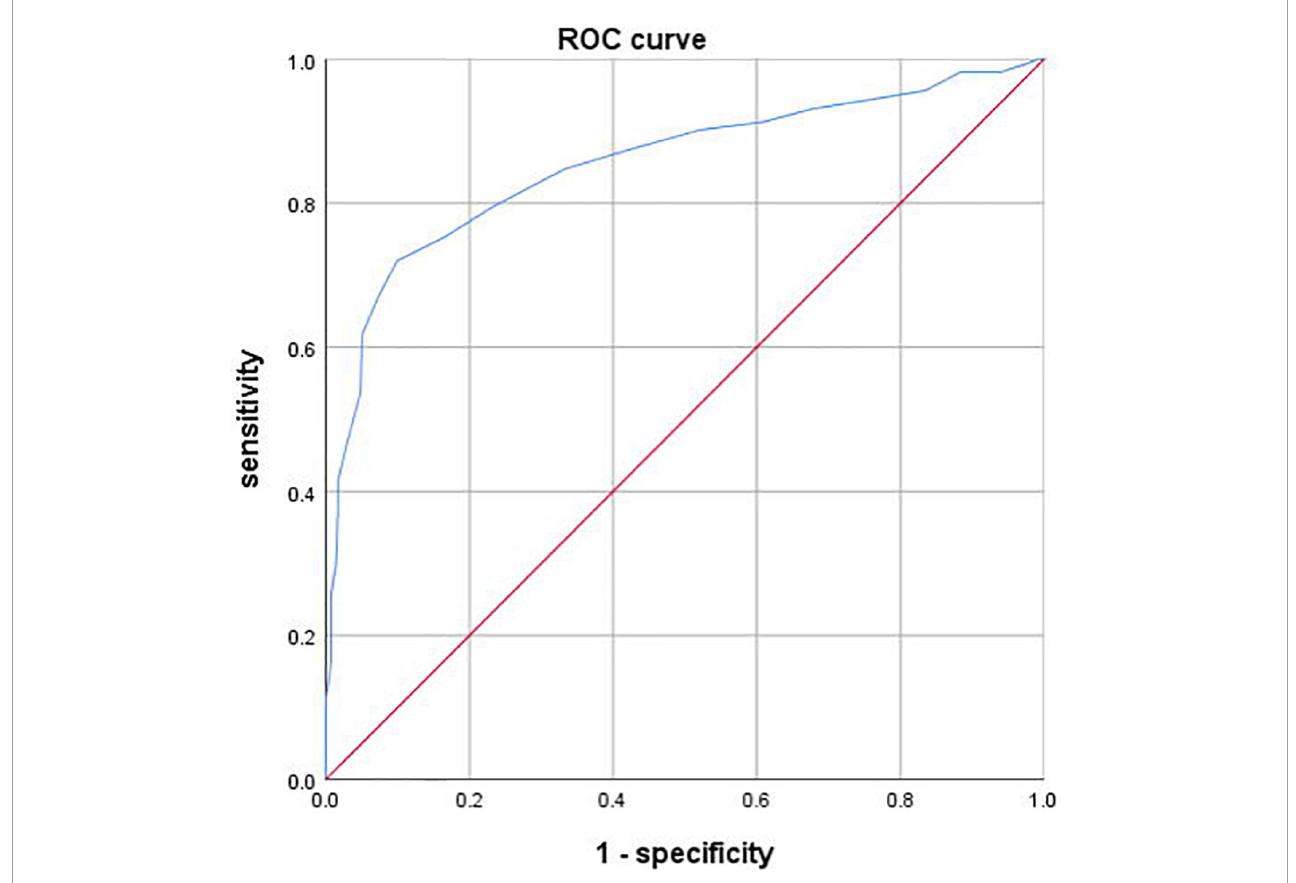
FIGURE3 Receiver operating characteristic (ROC) curve of FFRCT. The area under the receiver operating characteristic curve (AUC) was 0.86 (95% CI, 0.82–0.89).